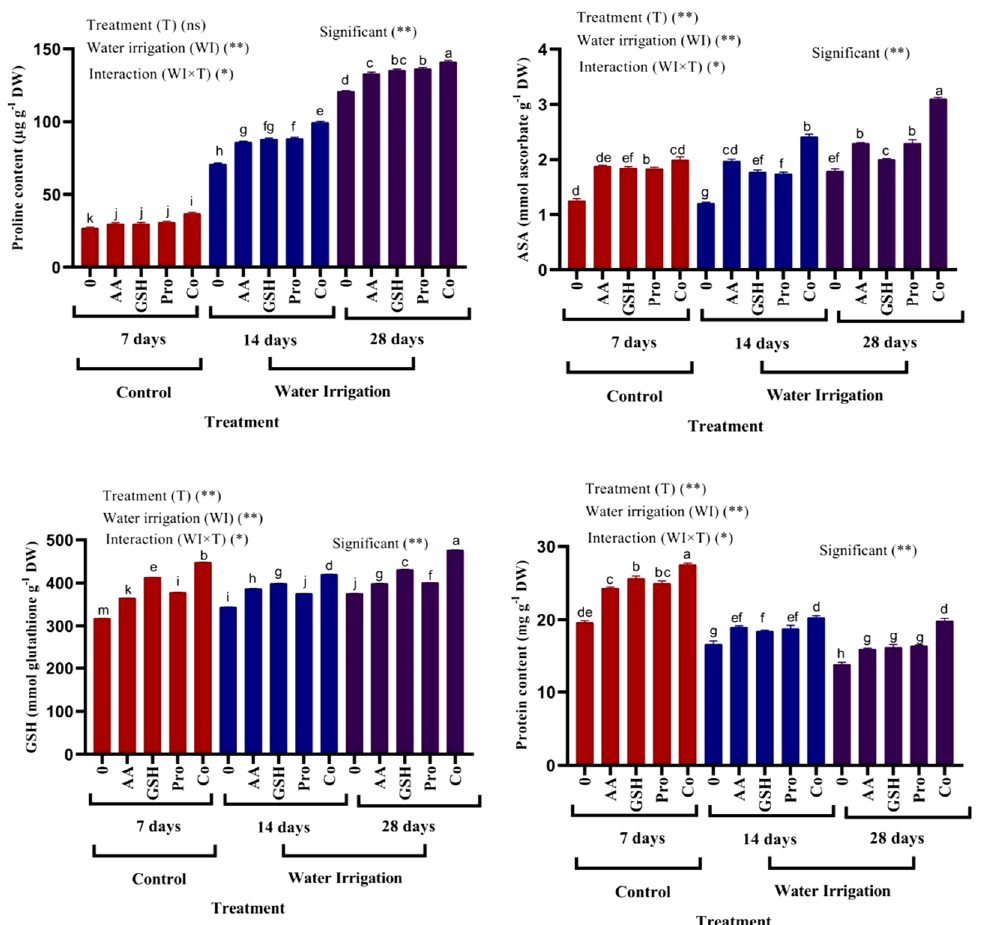
Figure 2. Effect of ascorbic acid, glutathione and proline on proline, non-enzymatic antioxidants and protein content in shoots of chickpea plants under different irrigation intervals. a, b, c, d, e, f, g, h: Different letters next to the mean values in each column indicate significant difference (LSD p ≤ 0.05). *and ** indicate different at p value <0.05, 0.01 probability level respectively, “ns” indicate non- significant.